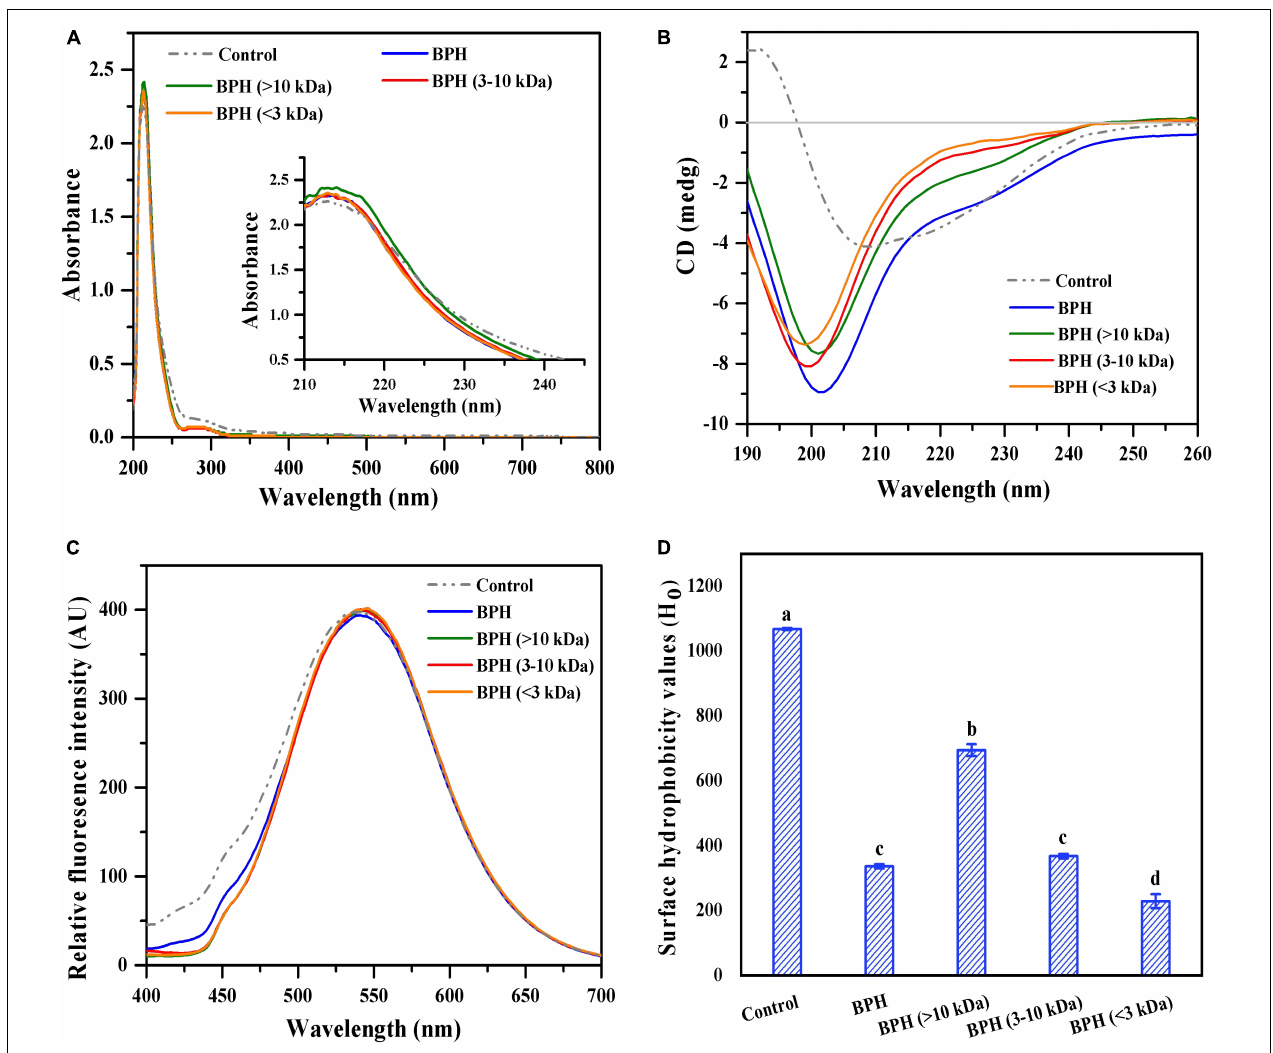
FIGURE 2 | UV-visible spectra of BPH and its membrane fractions (A) ; CD spectra of BPH and its membrane fractions (B) ; Fluorescence spectra of BPH and its membrane fractions (C) ; Surface hydrophobicity values (H o ) of BPH and its membrane fractions (D) . Different letters indicate the significant difference ( P <